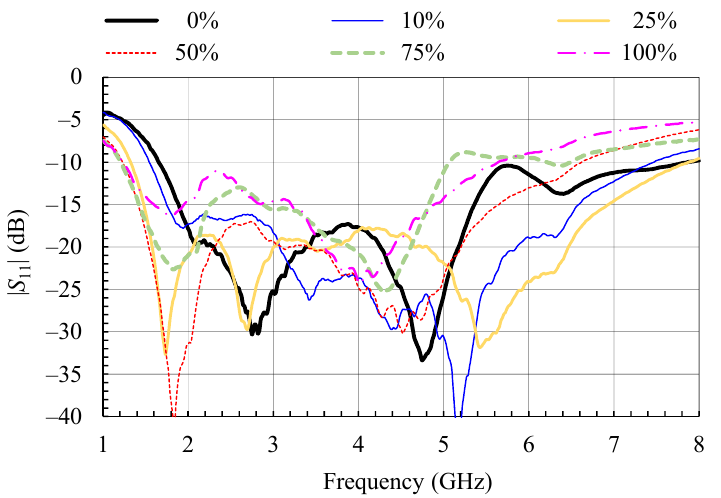
Figure 8. Measured magnitude of the input reflection coefficient of the wideband textile monopole for different moisture contents [14].